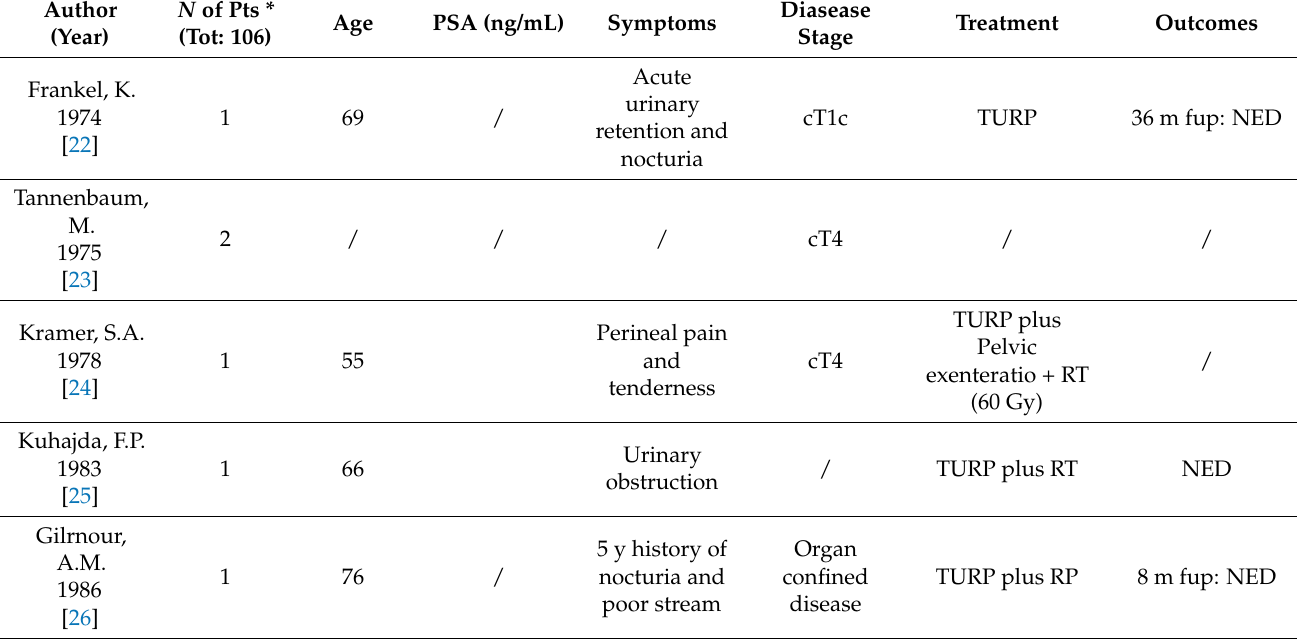
Table 2. Summary of case reports and case series published in the